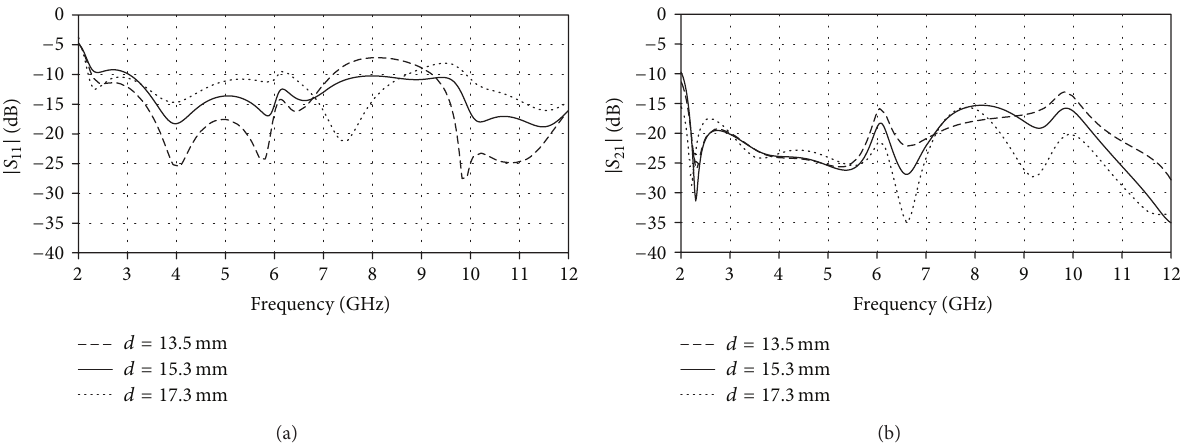
Figure 3: Simulated 𝑆 -parameters against frequency of the proposed antenna with different 𝑑 : (a) reflection coefficient |𝑆 11 | and (b) isolation | . |𝑆 21